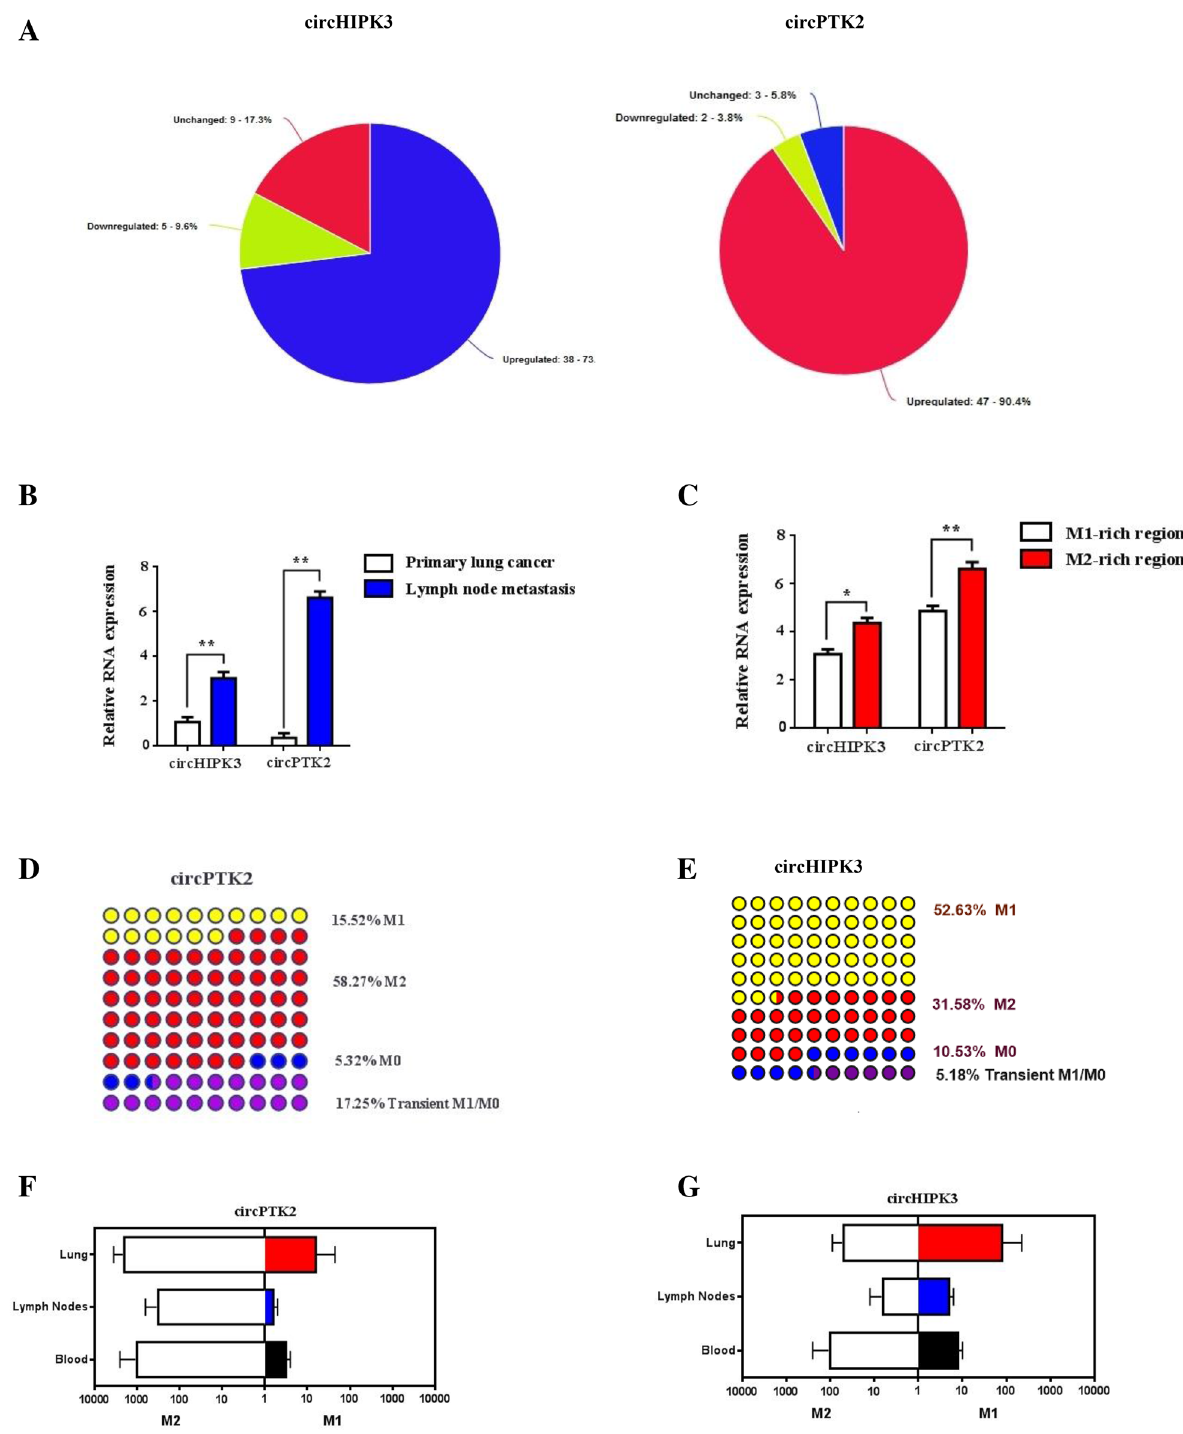
Figure 4. Augmented circHIPK3/PTK2 expression sustains Kras-driven intratumoral heterogeneity. ( A ) Expression profiles analysis of circHIPK3, circPTK2 in paired samples of NSCLC/Kras and adjacent non tumoral tissues by qRT-PCR. ( B ) qRT-PCR analysis of circHIPK3, circPTK2 expression in primary lung cancer and metastatic LN tissues. ( C ) Relative RNA expression of circHIPK3, circPTK2 isolated from tumor invasive front (M1-rich region) and stroma (M2-rich region) tissues. ( D , E ) Comparison percentage analysis of circHIPK3, circPTK2 levels in macrophage subsets (M0/M1/M2) from NSCLC patients, using qRT-PCR. ( F , G ) Relative degree of circHIPK3/circPTK2 enrichment in macrophage subpopulations isolated from lung, lymph nodes and blood respectively. Differences were considered statistically significant at p < 0.05. Statistically significant data are indicated by asterisks (*p < 0.05, **p <